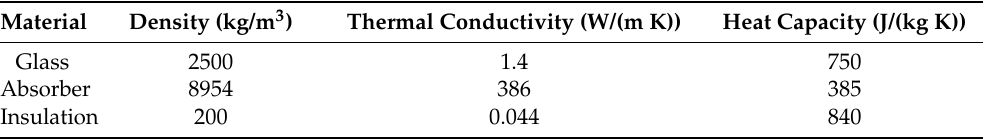
Table 3. FPC materials